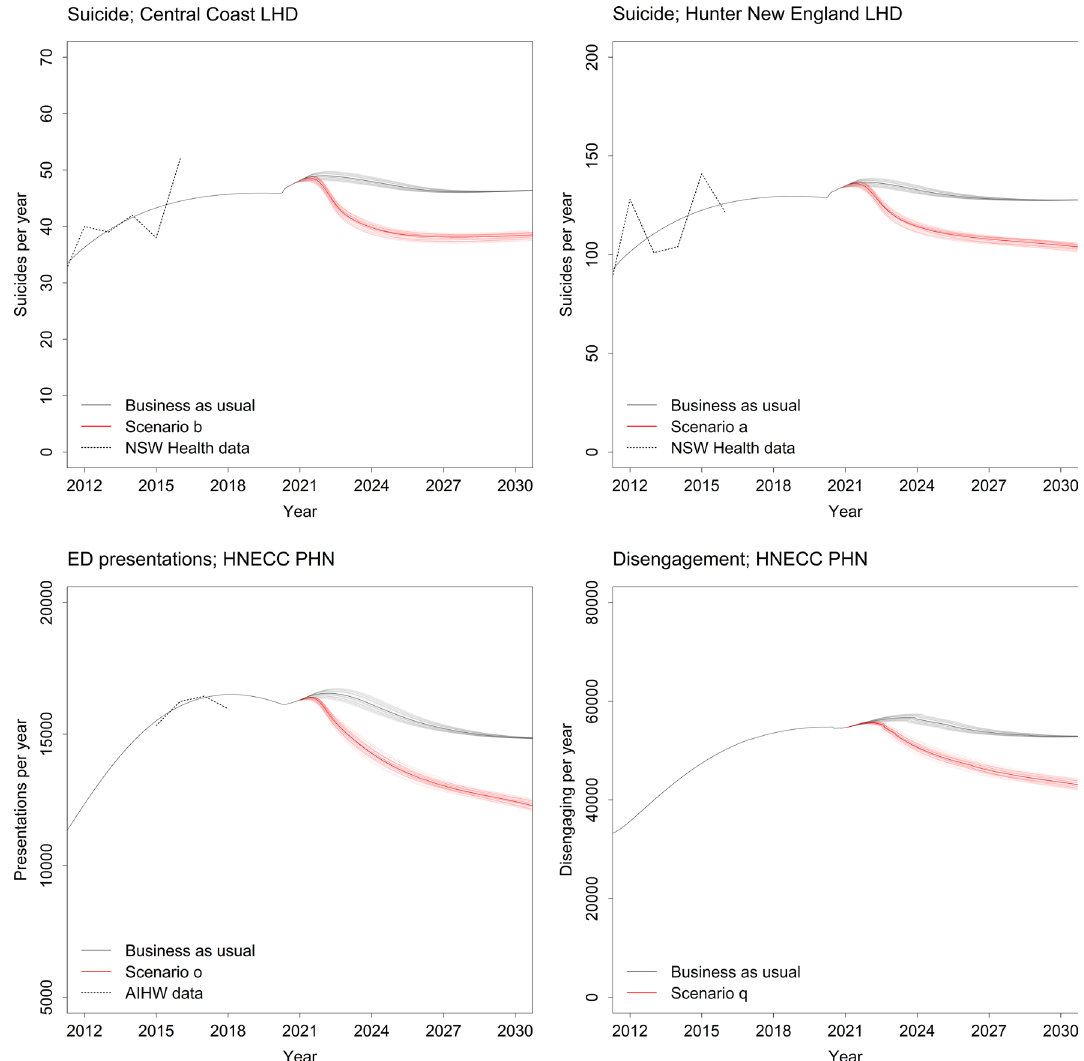
Figure 2. Numbers of suicides, emergency department (ED) presentations, and patients disengaging from services per year under the baseline scenario (i.e., business as usual) and the optimal intervention scenario for each outcome (see Table 2 for intervention scenario details). The dotted lines show estimates of numbers of suicides and ED presentations published by NSW Health (http:// www. healt hstats. nsw. gov. au) and the Australian Institute of Health and Welfare (2019). Model outputs from the sensitivity analyses, incorporating uncertainty in the intervention effects and the duration of increased distress onset due to the COVID-19 pandemic, are shown as lighter solid lines; the heavier solid lines show model outputs obtained assuming the default parameter